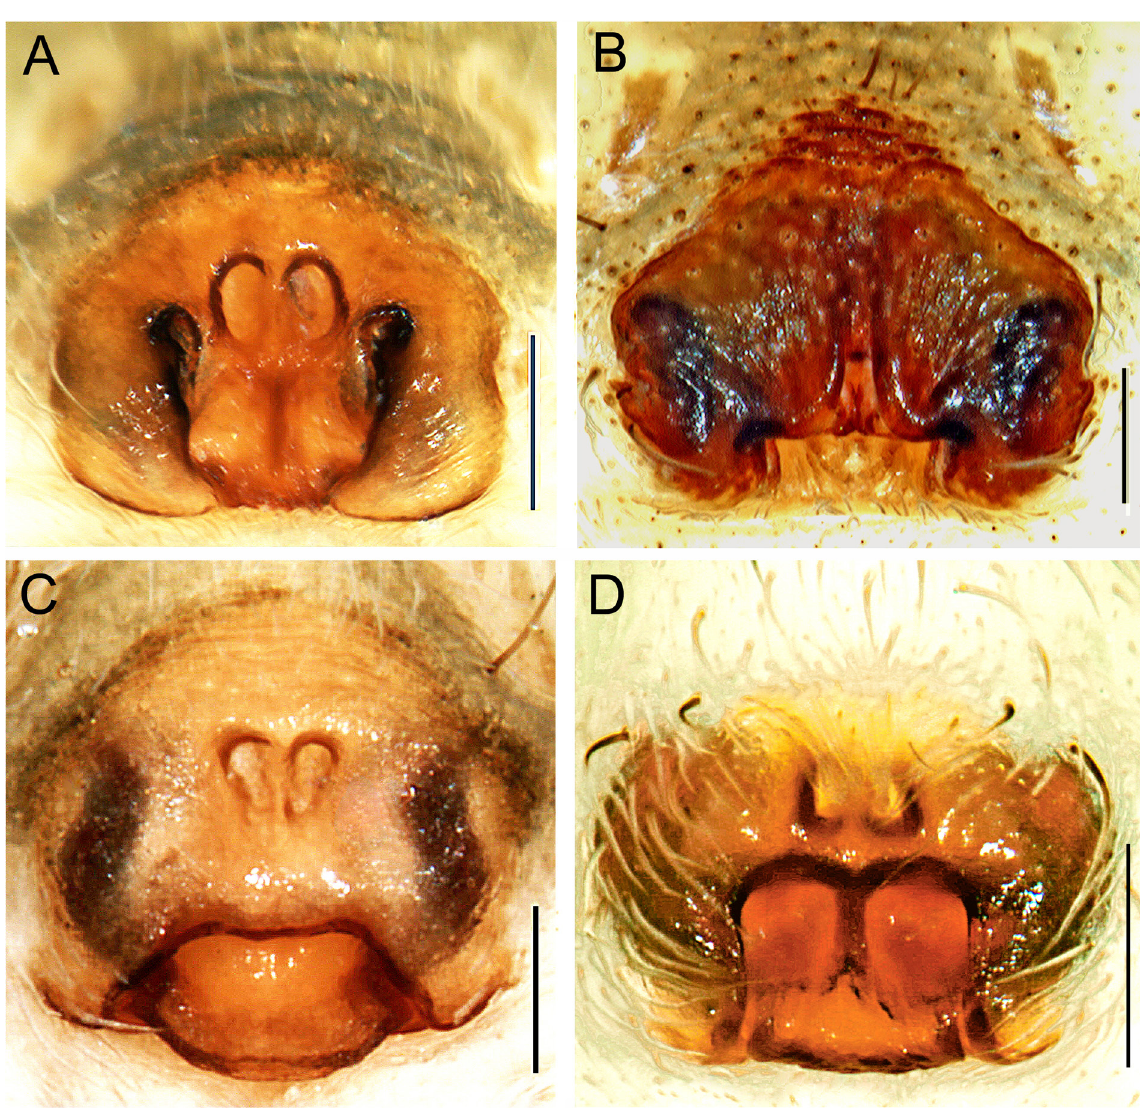
Fig. 7. Epigyne, ventral view. — A . Wadicosa benadira (Caporiacco), from Kenya, Tsavo East NP. — B . W. cognata sp. nov., allotype. — C . W. jocquei sp. nov., from Madagascar, Mahafaly. — D . W. russell- smithi sp. nov., holotype. Scale bars = 0.2